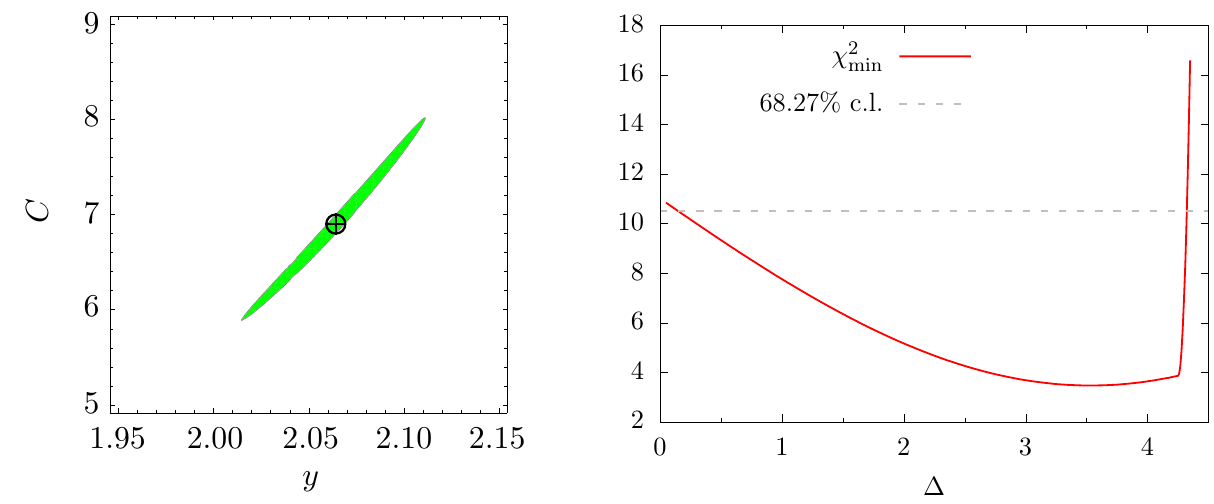
Figure 1. The 1 σ ranges for the scaling dimensions y and ∆ , as defined in the main body 68 . 27% c.l. contour obtained from the six-parameter global fit, restricted to the Figure 2 . The Figure 3 . The chi-squared minimum as a function of  , obtained from the six-parameter global of the paper, obtained in fits of LSD lattice measurements in the SU ( 3 ) theory with N f = 8 C by marginalising over all other variables. parameters y and fit to the LSD data using Eqs. (2.13)-(2.15). The grey dashed line represents the value of the  2 fundamental fermions corresponding to the 68 . 27% c.l. interval. In making the plot, we marginalised over the remaining five fit parameters.